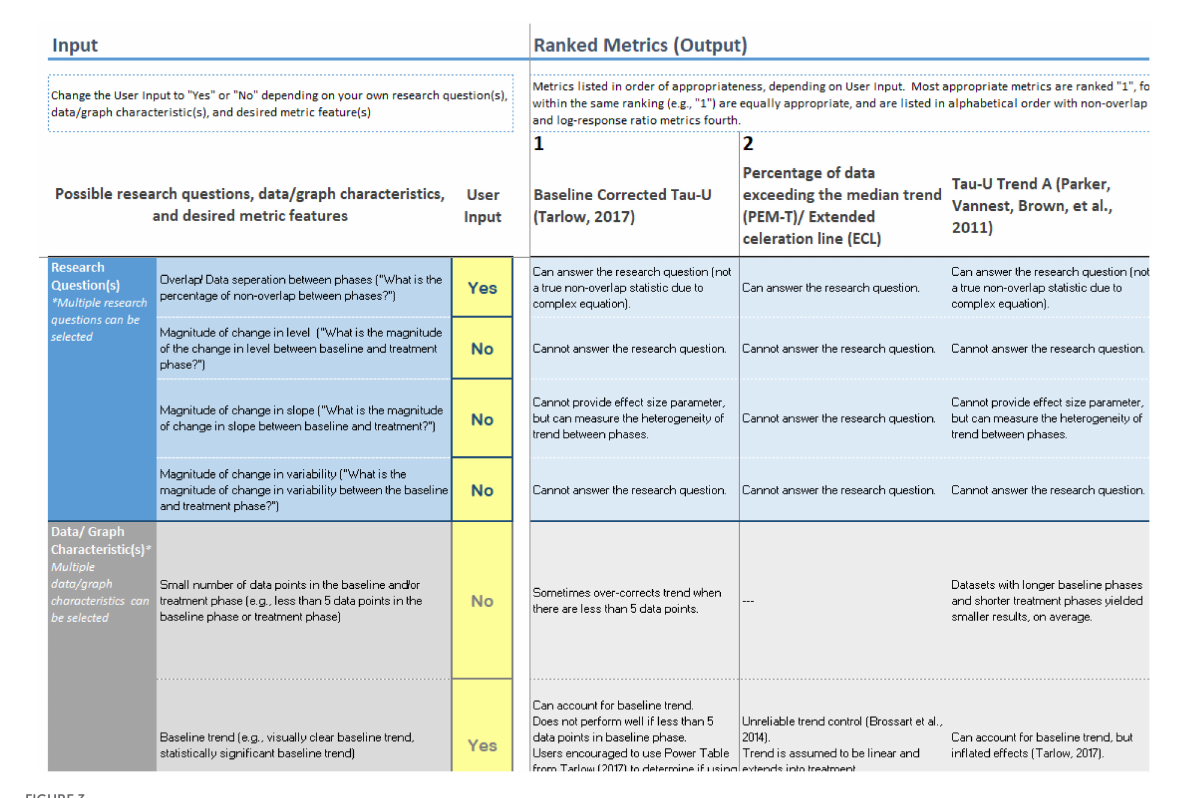
FIGURE3 Tool input and output with ranked quantification techniques. As this is only a screenshot of the tool, readers are encouraged to download the tool themselves to read more details at: